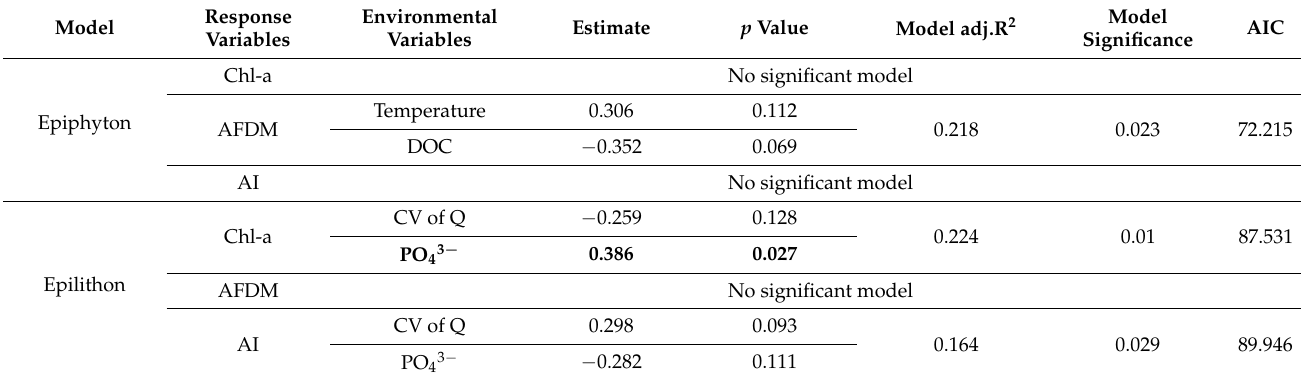
Table 1. Multiple regression models on biomass and AI of epiphyton and epilithon ( p < 0.05 and lowest AIC) for all data from the two study streams. Significant variables in the models are shown in bold. All environmental data derived from measurements were taken in the period of 21 days before sampling date (Figure 1).